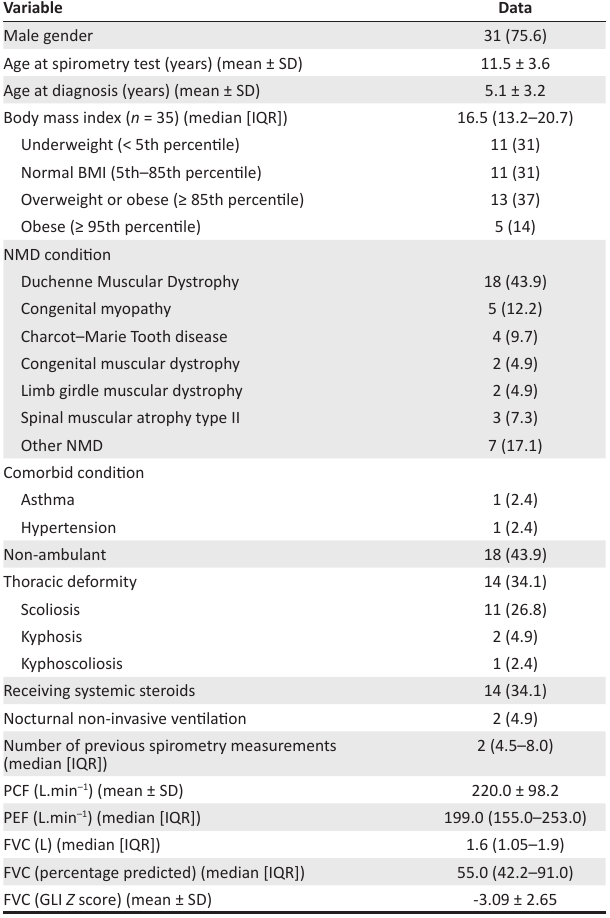
TABLE 1: Participant characteristics ( n =